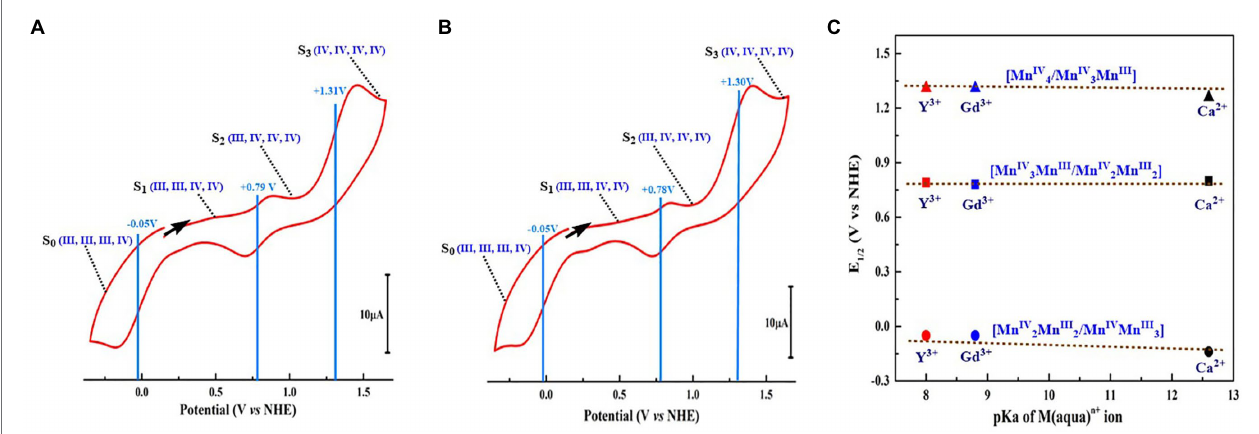
FIGURE 11 | Redox potentials of the Mn 4 YO 4 -cluster ( 10 ) and Mn 4 GdO 4 -cluster ( 11 ) (Yao et al., 2021). (A) CV of Mn 4 YO 4 -cluster. (B) CV of Mn 4 GdO 4 -cluster. The possible oxidation states of the four Mn ions are shown in blue. The scan direction is indicated by the arrow. (C) Dependence of E1/2 of three redox couples on pKa of the X(aqua) n+ ion (Perrin, 1982) of three Mn4XO4-clusters. All potentials were referenced to